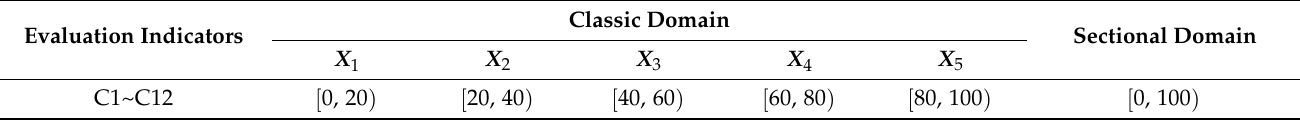
Table 15. Classical and sectional domains in the construction safety risk evaluation index.